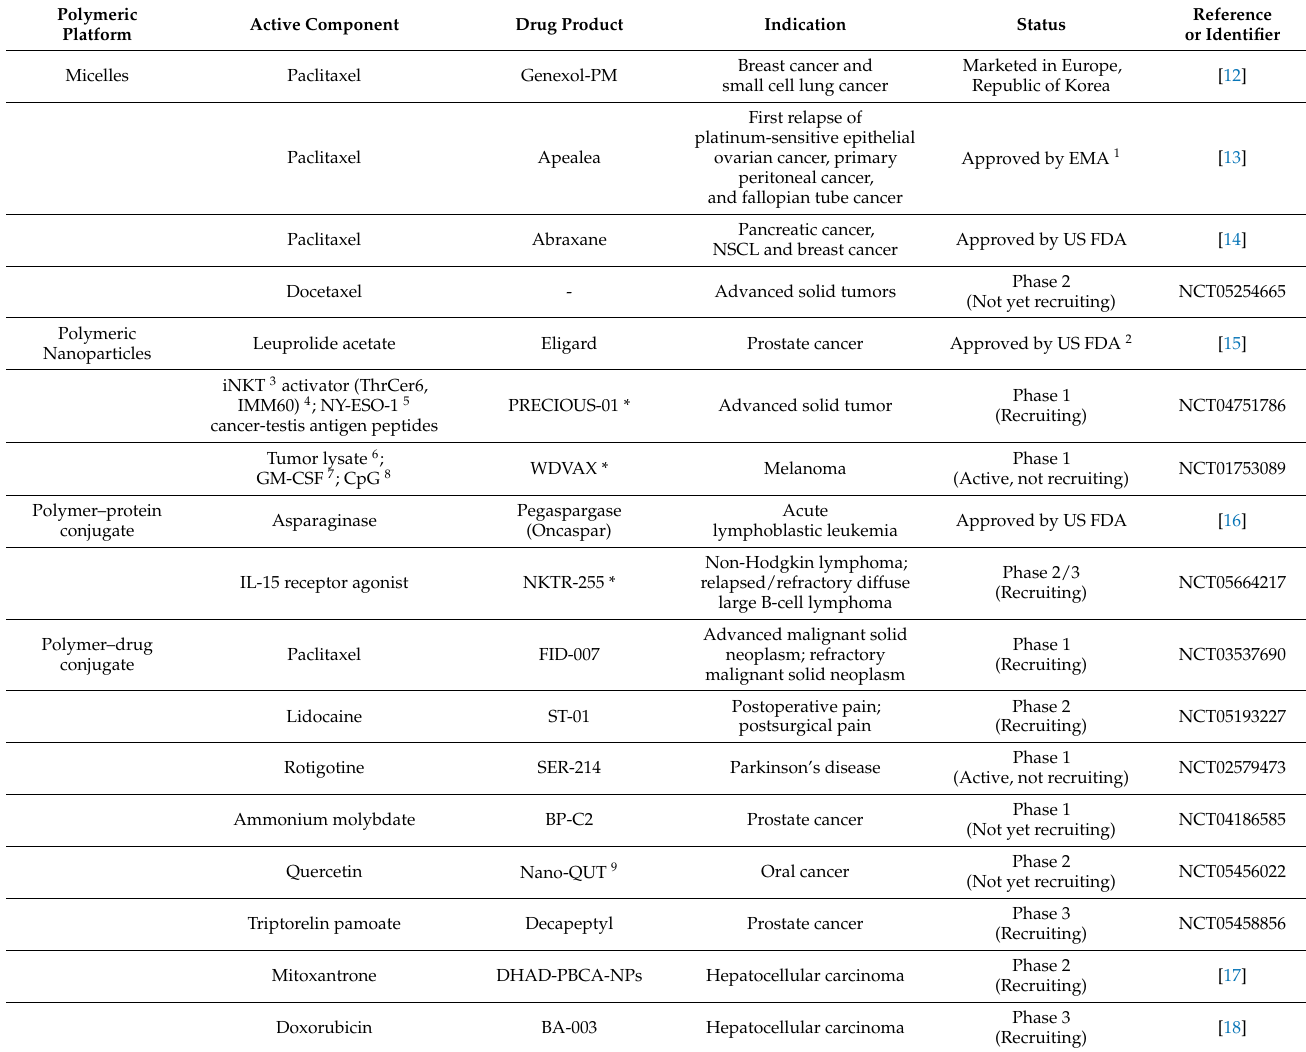
Table 1. Polymeric nanoparticles in clinical use or under clinical